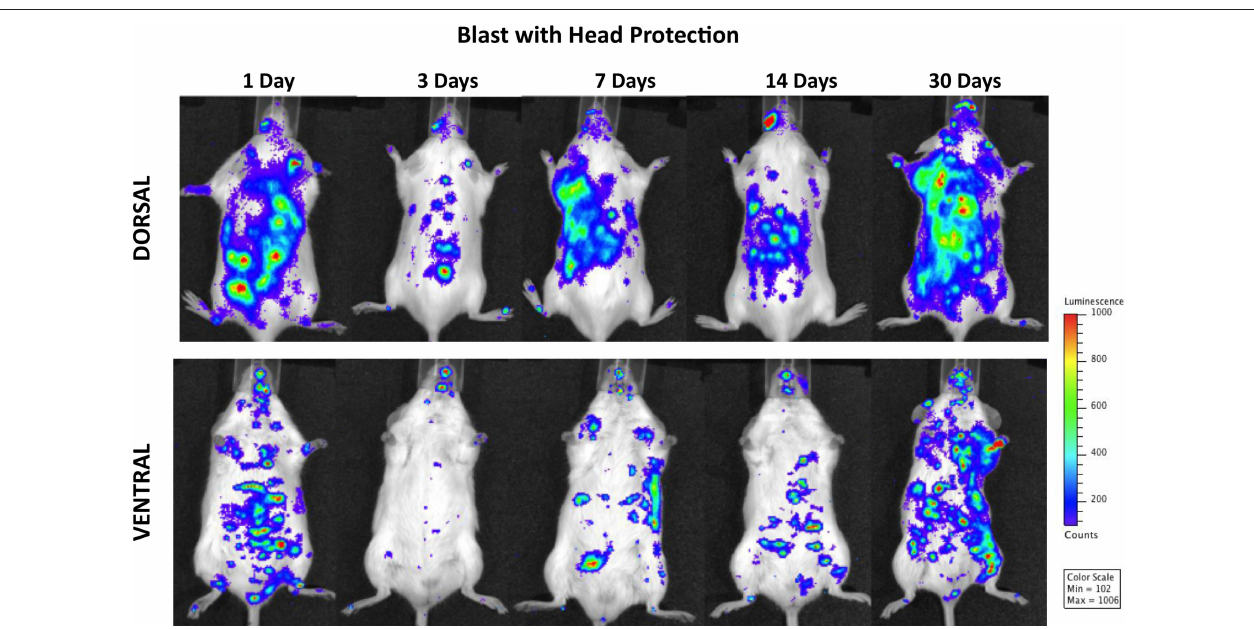
Figure 4 | Distribution of increased bioluminescence showing MPO activity in mice subjected to blast with head protection, imaged during the 1-month observation period. The representative photographs show the same animal imaged in both dorsal and ventral positions at the given time point after